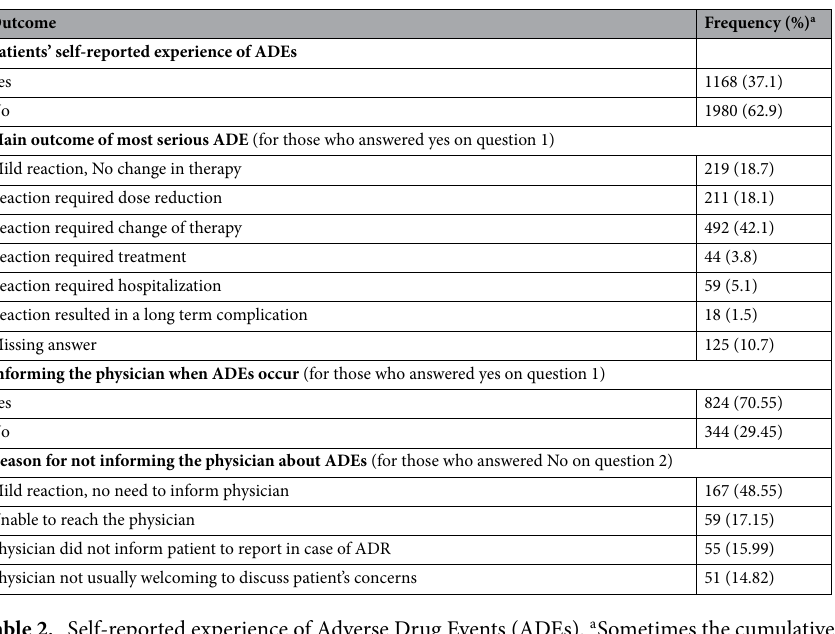
Table 2. Self-reported experience of Adverse Drug Events (ADEs). a Sometimes the cumulative percentages may not reach 100% due to missing values. When missing values are less than 10%, they were not reported explicitly.